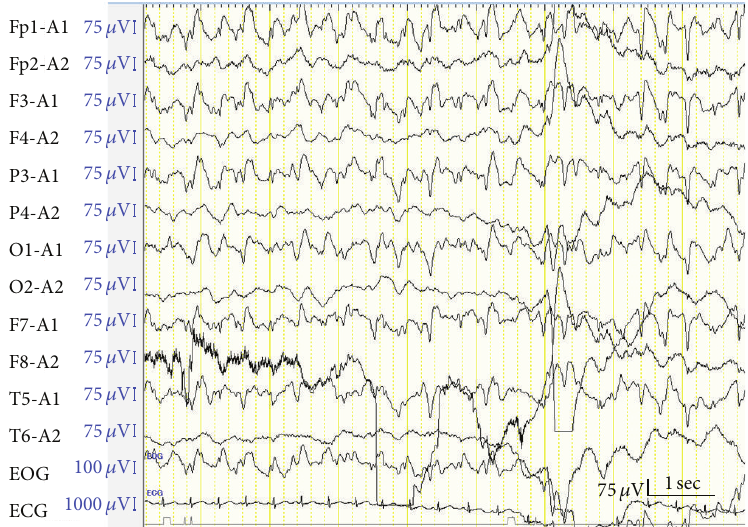
Figure 3: An ictal electroencephalogram during the seizure. The spike and slow wave complexes, which synchronized with apneic attacks, in left cerebral hemisphere can be